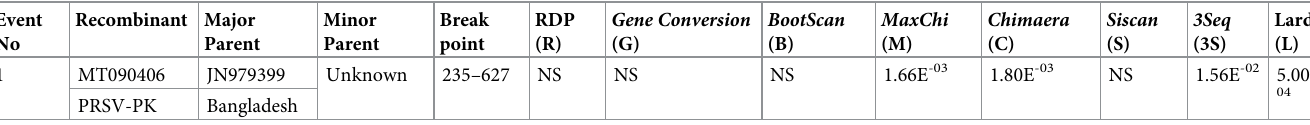
Table 3. Recombination detection in CP gene of atypical PRSV-P Isolate PK